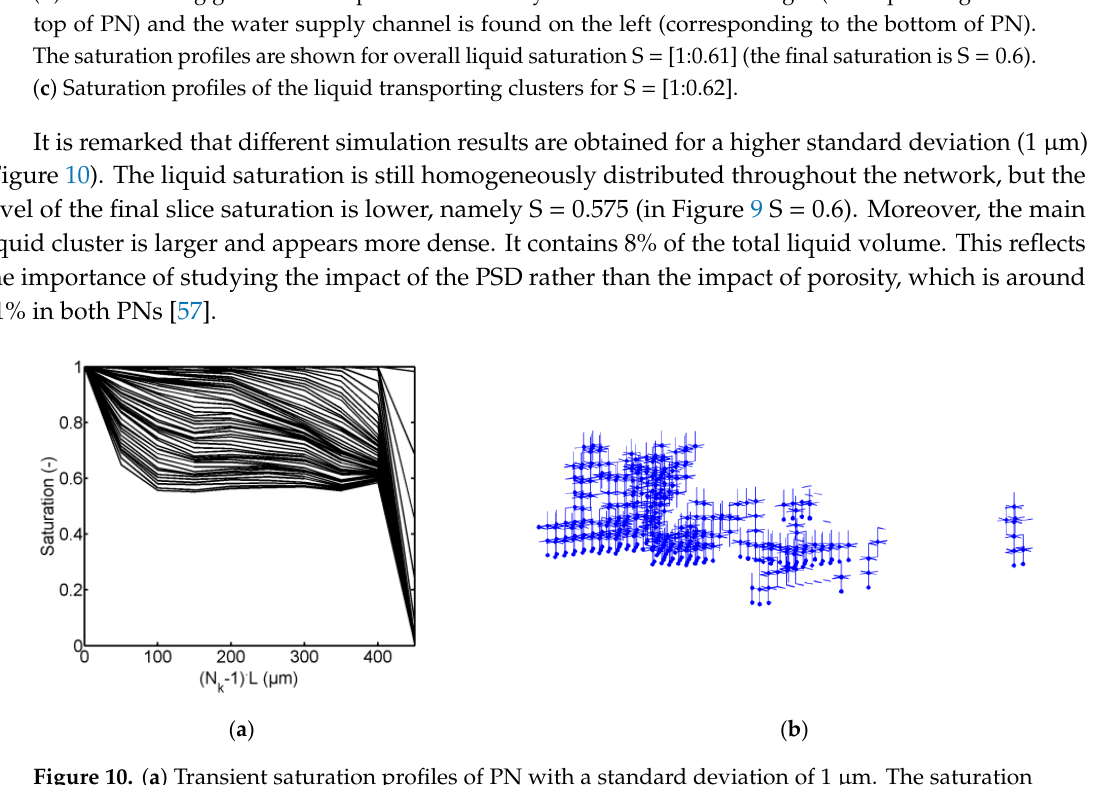
Figure 10. ( a ) Transient saturation profiles of PN with a standard deviation of 1 µm. The saturation profiles are shown for overall liquid saturation S = [1:0.58] (the final saturation is S = 0.575). ( b ) Main cluster.